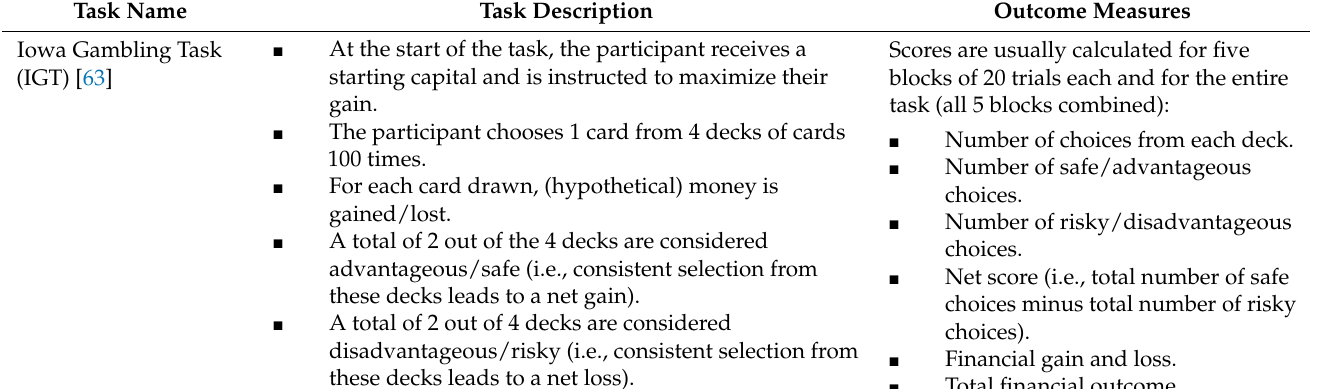
Table 1. Overview and description of identified risky decision-making